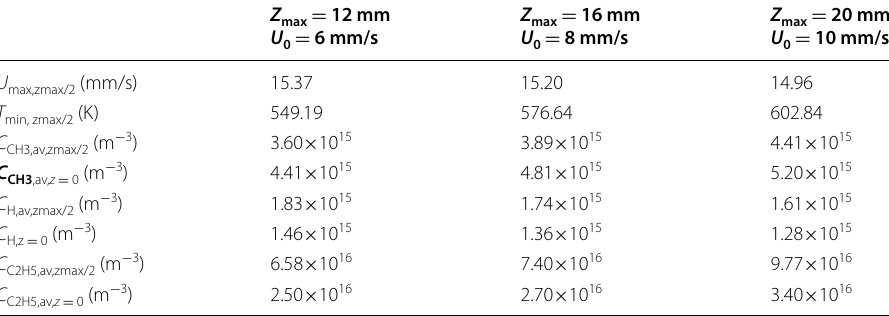
Table 5 Effect of distance filaments-substrates on concentrations for n